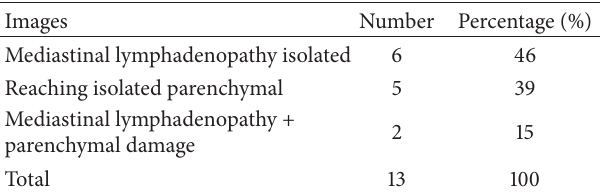
Table 1: Radiographic images of